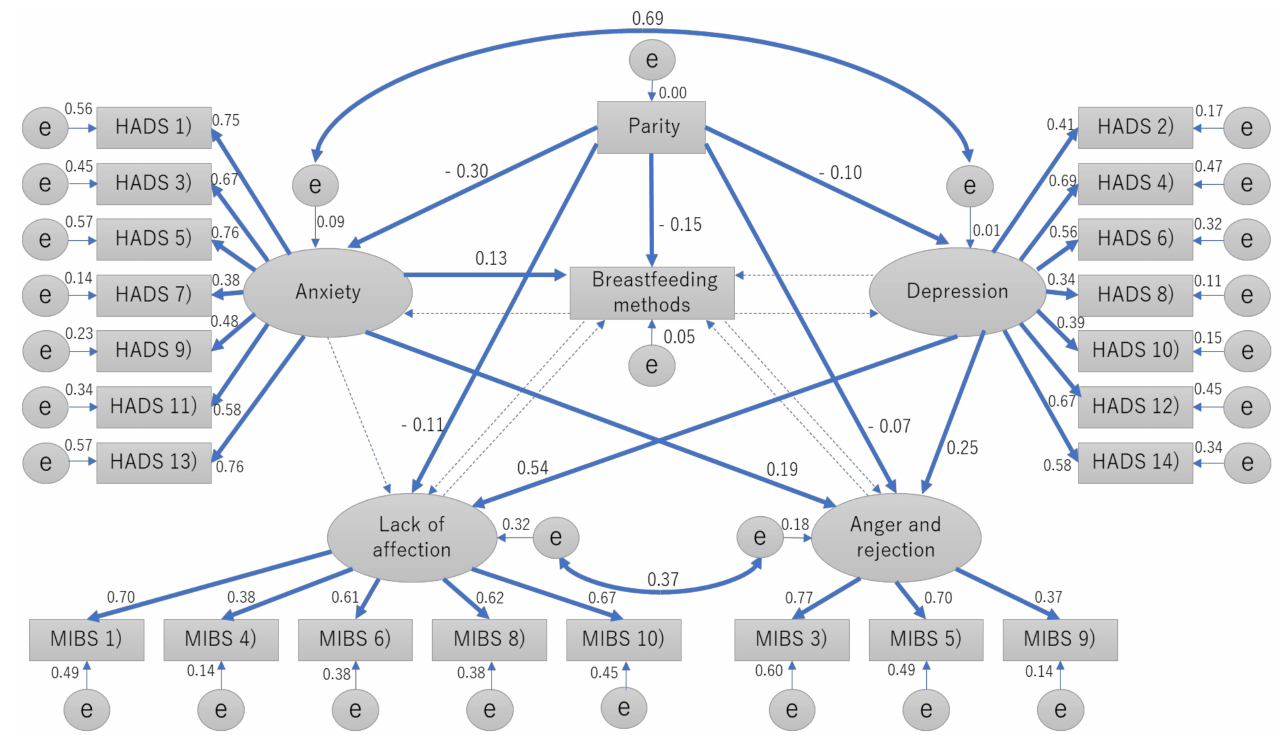
Figure 1. Path model of the associations between breastfeeding methods, parity, depression, anxiety, and maternal–infant bonding in the early postpartum period. Significant paths are shown in bold. Abbreviations: HADS, Hospital Anxiety and Depression Scale; MIBS, Mother-to-Infant Bonding